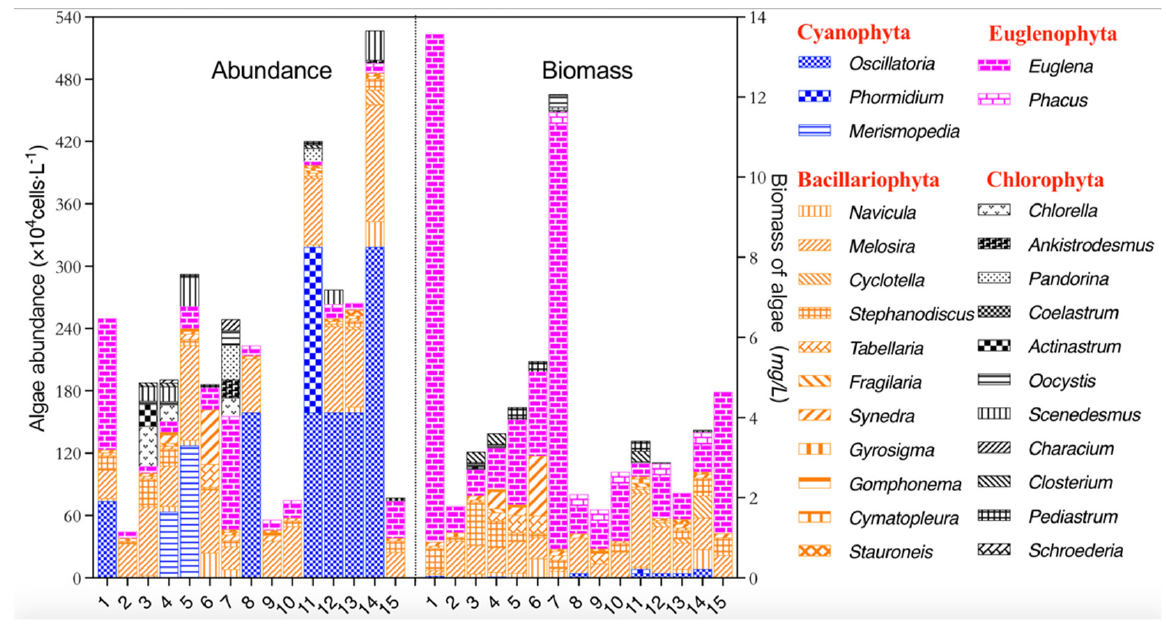
Figure 2. The composition characteristics of algae abundance and biomass in different sampling sites. Note: The codes for each sampling site are shown in Figure 1.